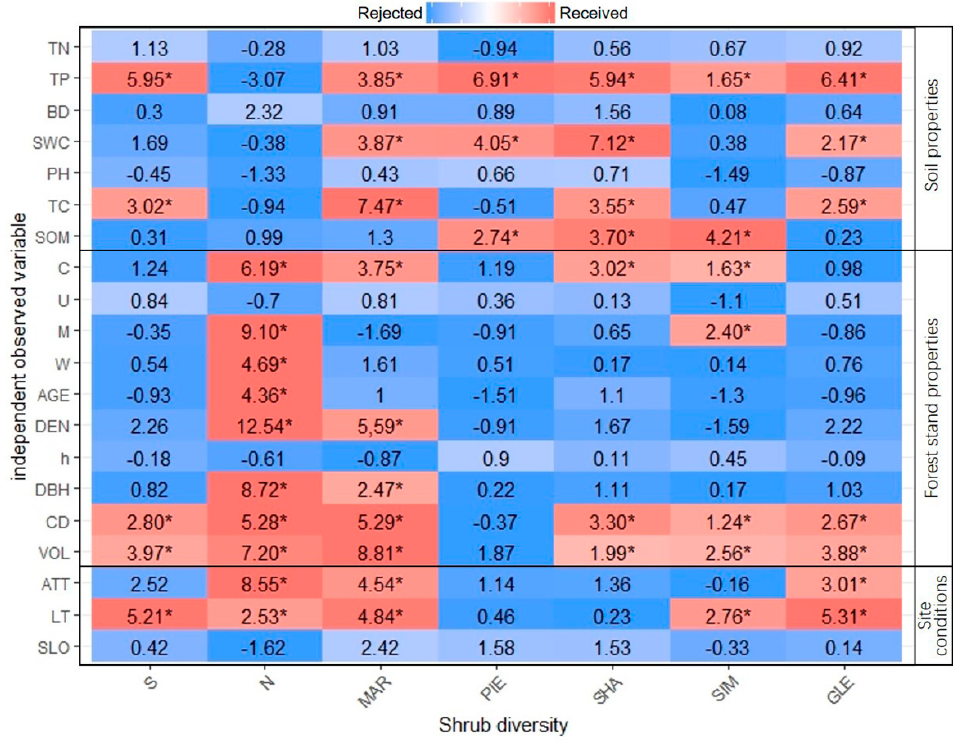
Figure 3. Factor significance by Random Forest algorithm, * indicate the significance of independent observed variables which selected by dependent observed variables. TN, total nitrogen content; TP, total phosphorus content; BD, bulk density; SWC, soil water content; PH, power of hydrogen; TC, total carbon content; SOM, soil organic matter; C, crowding index; U, dominance index; M, mingling index; W, uniform angle index; AGE, average age of the tree; DEN, stand density; h, tree height; DBH, diameter at breast height; CD, canopy density; VOL, forest stock volume; ATT, altitude; LT, litter thickness; SLO, slope; S, total shrub species, N, total number of individual shrub; MAR, Margalef index, PIE, Pielon index, SHA, Shannon-Wiener index; SIM, Simpson index; GLE, Gleason index.